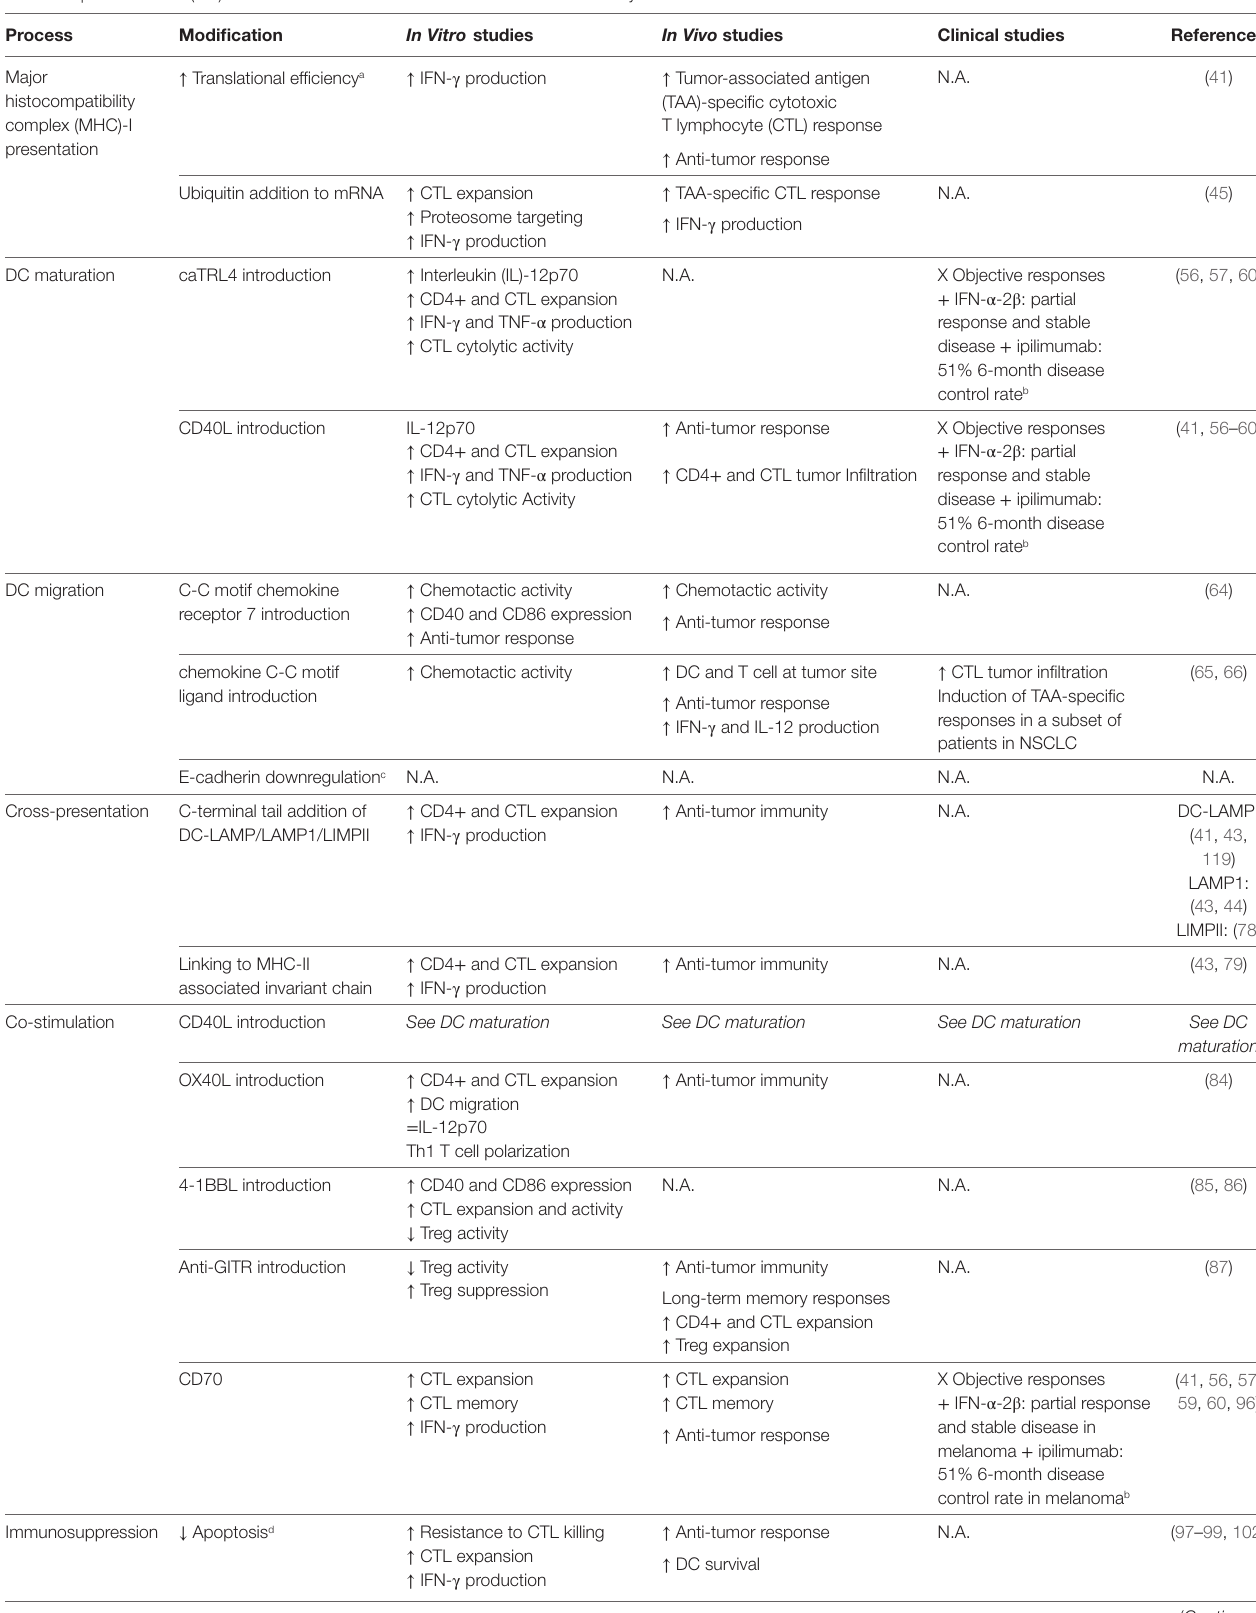
TABLe 1 | Dendritic cell (DC) modifications to enhance anti-tumor induced